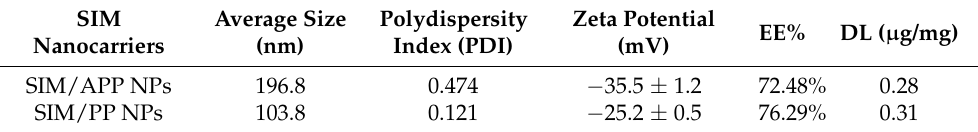
Table 2. The size distribution, zeta potential, encapsulation efficiency (EE%), and drug loading (DL) capacity of the simvastatin nanocarriers were measured by dynamic light scattering (DLS), zeta potential analysis, and high-performance liquid chromatography